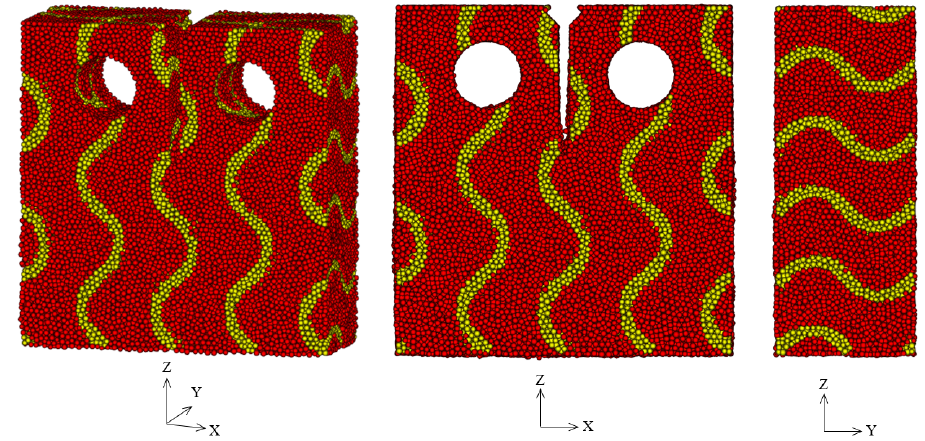
Figure 6. Views of the DEM domain of the Z-orientation gyroid (Gyroid_01). The gyroid is represented by yellow discrete elements which correspond to the MS-TiC particles, whereas red elements correspond to the MS